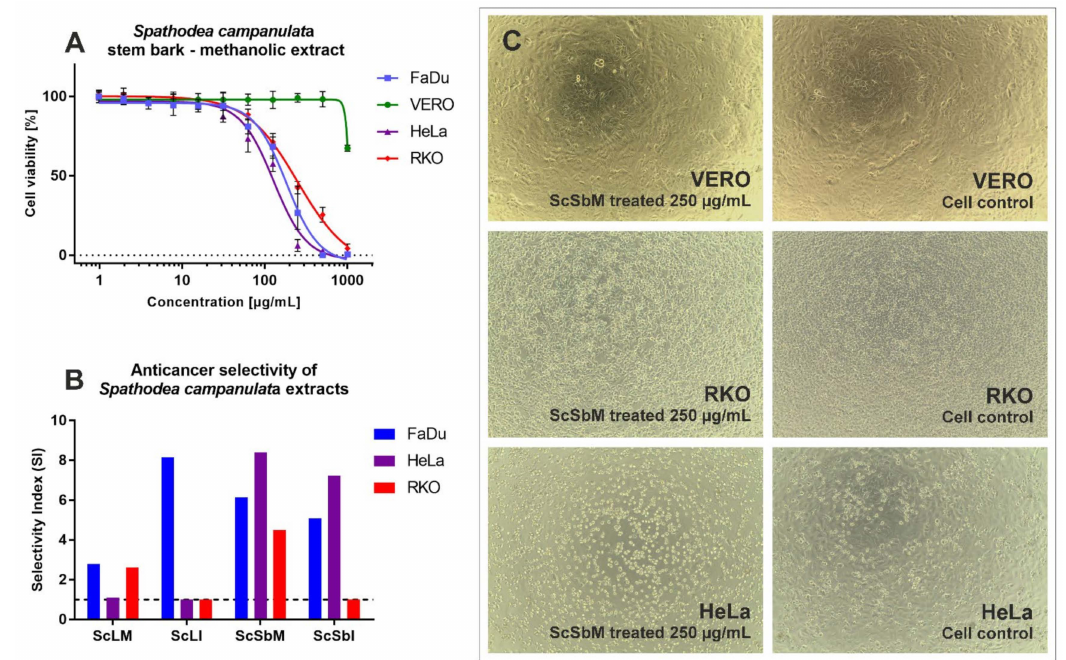
Figure 3. The influence of S. campanulata extracts on normal and cancer cells: ( A )—dose–response curves of ScSbM in normal and cancer cells; ( B )—comparison of selectivity indexes obtained for S. campanulata extracts; ( C )—influence of ScSbM 250 µ g/mL on VERO, RKO, and HeLa cells (magnification ×